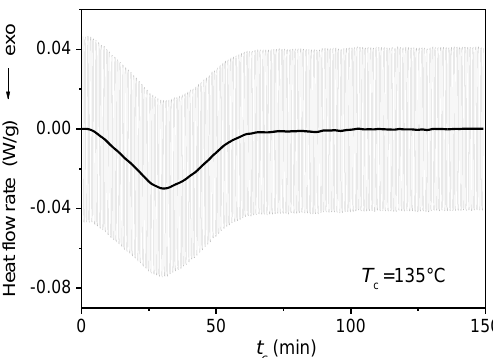
Figure 5. Crystallization time ( t c ) evolution of the modulated heat flow rate ( HF mod : grey line) and average heat flow rate ( HF : black line) during quasi-isothermal crystallization of PLLA ( p = 60 s, A T = 0.4 K) at T c = 135 °C. (Reprinted (adapted) with permission from [34]. Copyright (2011) Elsevier).